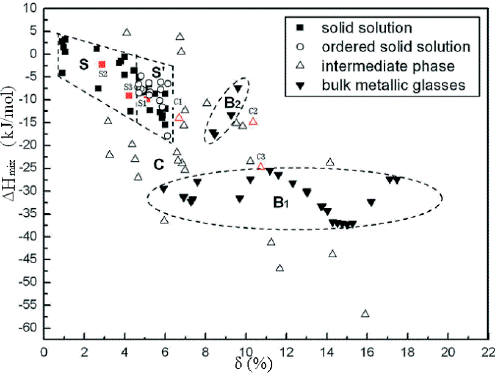
Figure 3. Relationships of phase selection, atomic size difference δ , and mixing enthalpy Δ H mix [26].